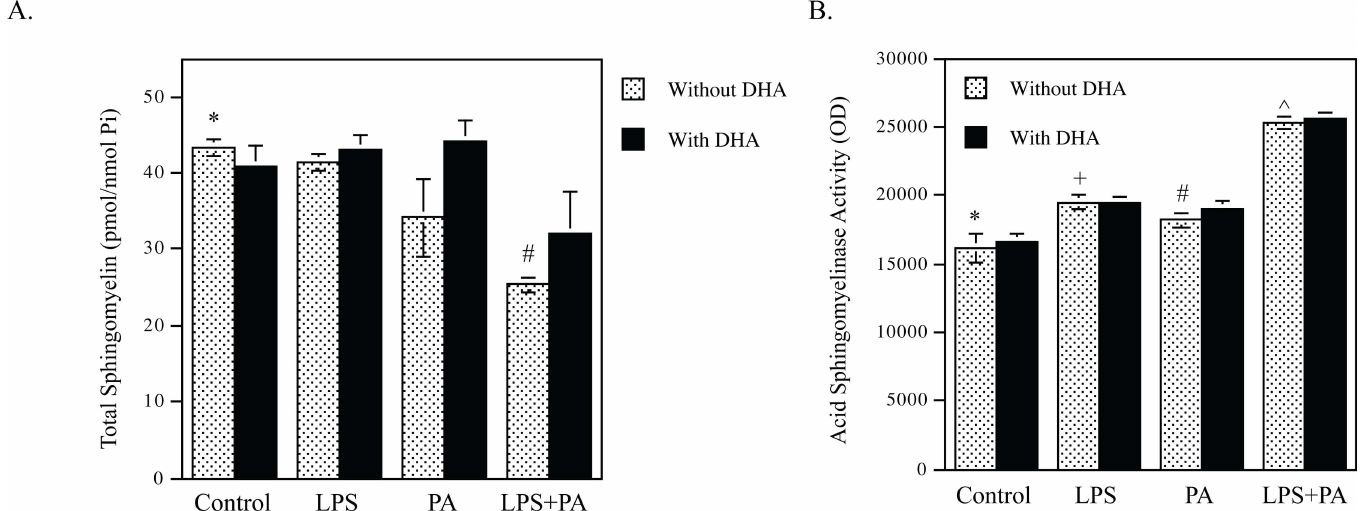
Fig 3. DHA has no effect on SM hydrolysis and ASMase activity stimulated by LPS and PA. A. RAW264.7 macrophages were treated with 1 ng/ml of LPS, 100 μ M of PA or both 1 ng/ml LPS and 100 μ M of PA in the absence or presence of 100 μ M of DHA for 12 h. After treatment, cellular sphingomyelin was quantified using lipidomics. (cid:3) vs. #, p < 0.01. B. RAW264.7 macrophages were treated with 1 ng/ml of LPS, 100 μ M of PA or both 1 ng/ml LPS and 100 μ M of PA in the absence or presence of 100 μ M of DHA for 2 h. After treatment, cellular ASMase activity was determined as described in the Methods. (cid:3) vs. +, p < 0.05; (cid:3) vs. #, p < 0.05; (cid:3) vs. ^, p < 0.05.